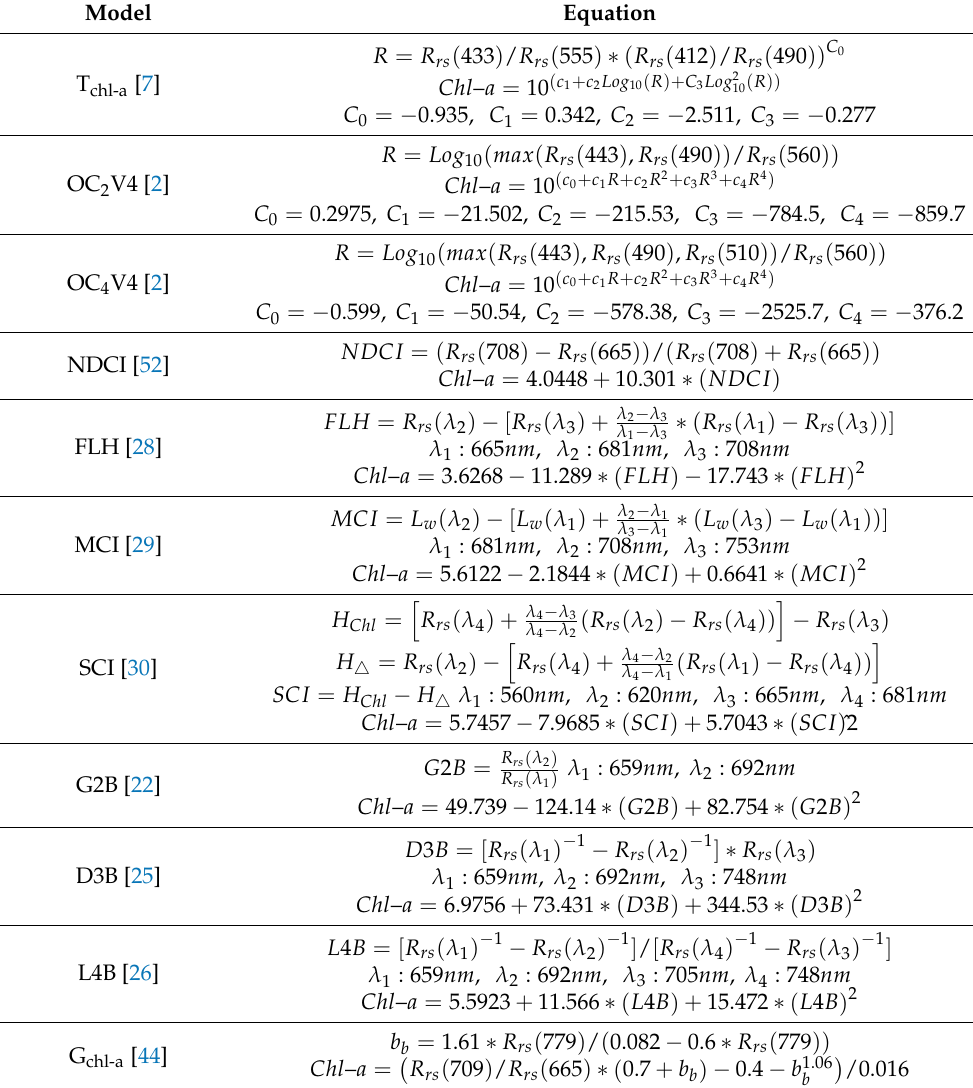
Table 2. Brief descriptions of the 11 types of chl-a retrieval algorithms used in this study.